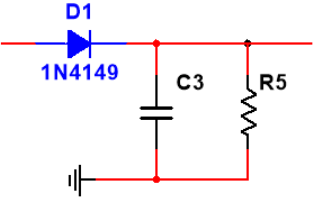
Figure 5. Envelope detection circuit.